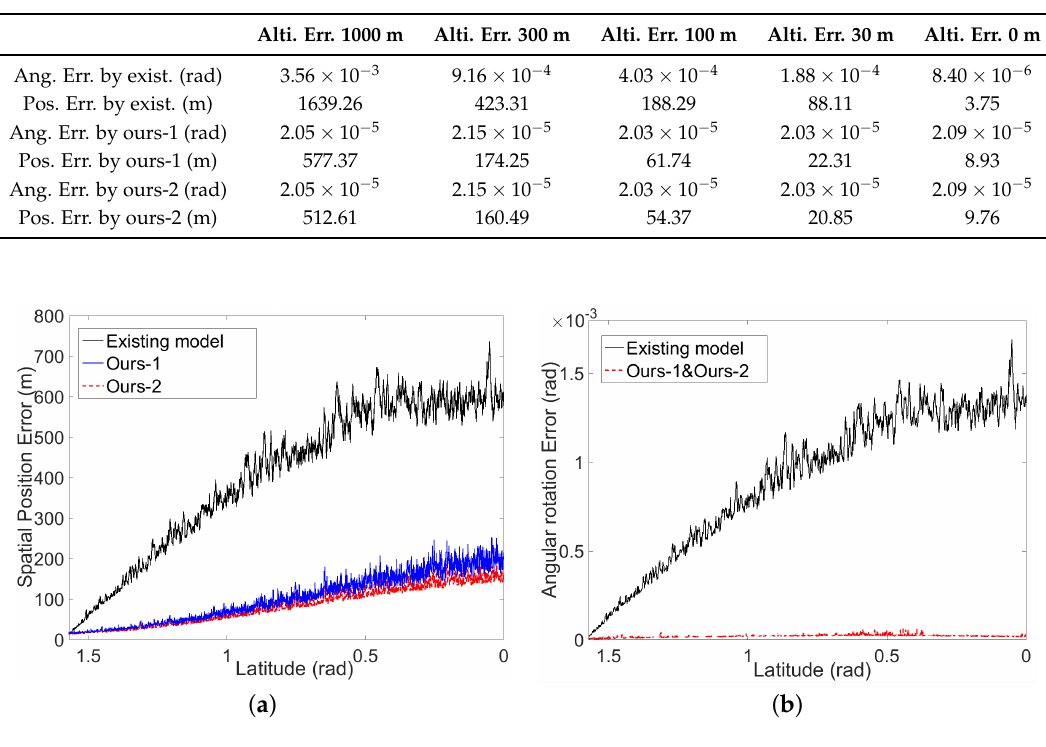
Figure 8. Errors of the estimated EOPs covering the trajectory from the pole ( π /2 latitude) to the Equator (0 latitude). ( a ) The errors of the estimated spatial position; ( b ) the errors of the estimated angular rotation. The red and black curves indicate the results by our model and the existing model,